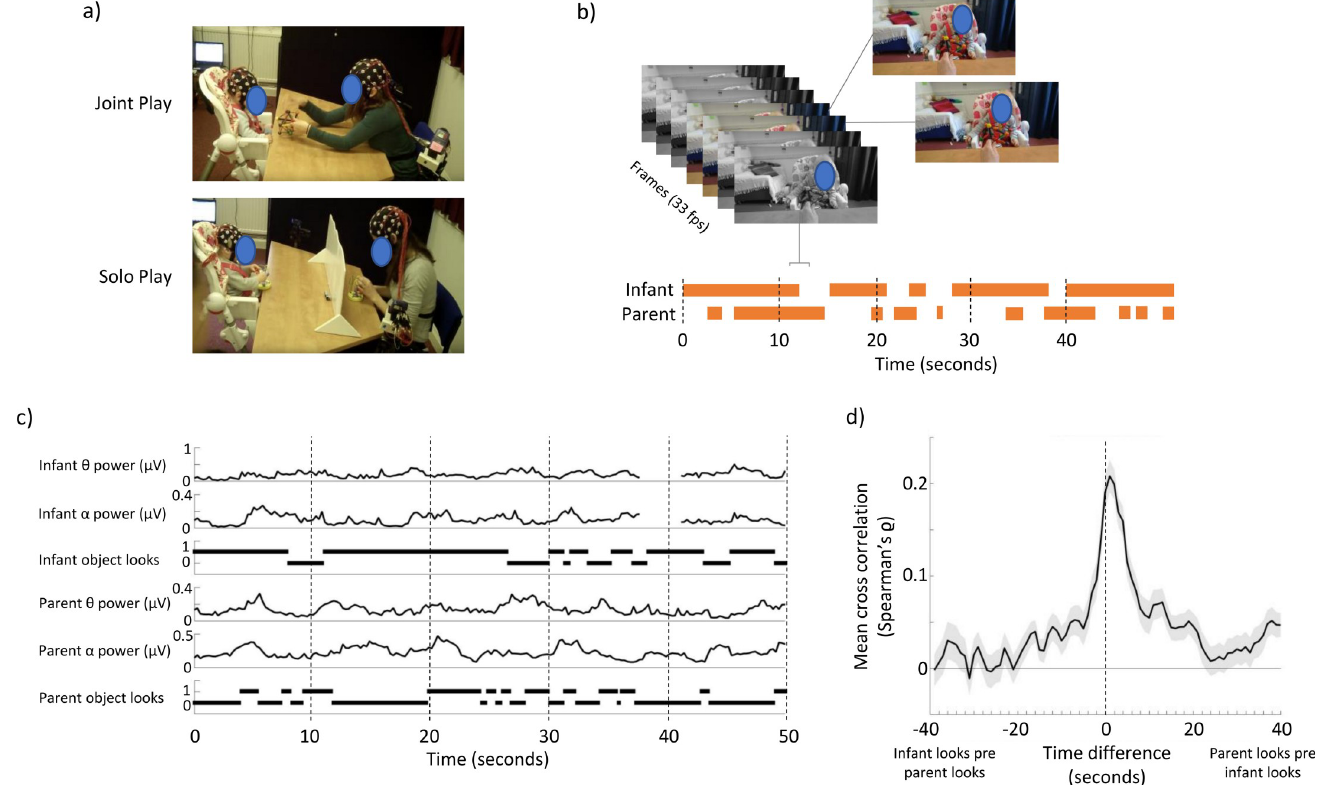
Fig 1. Experimental overview. (a) Demonstration of experimental set-up; (b) illustration of visual coding that was applied to the data; (c) illustration of raw data. EEG data were decomposed using a Fourier decomposition, and power within continuous bins was calculated, epoched to 4 Hz; (d) cross-correlation showing the relationship between infant object looks and parent object looks [see 25]. The underlying data for this figure can be found in S1 Text.EEG, electroencephalography.